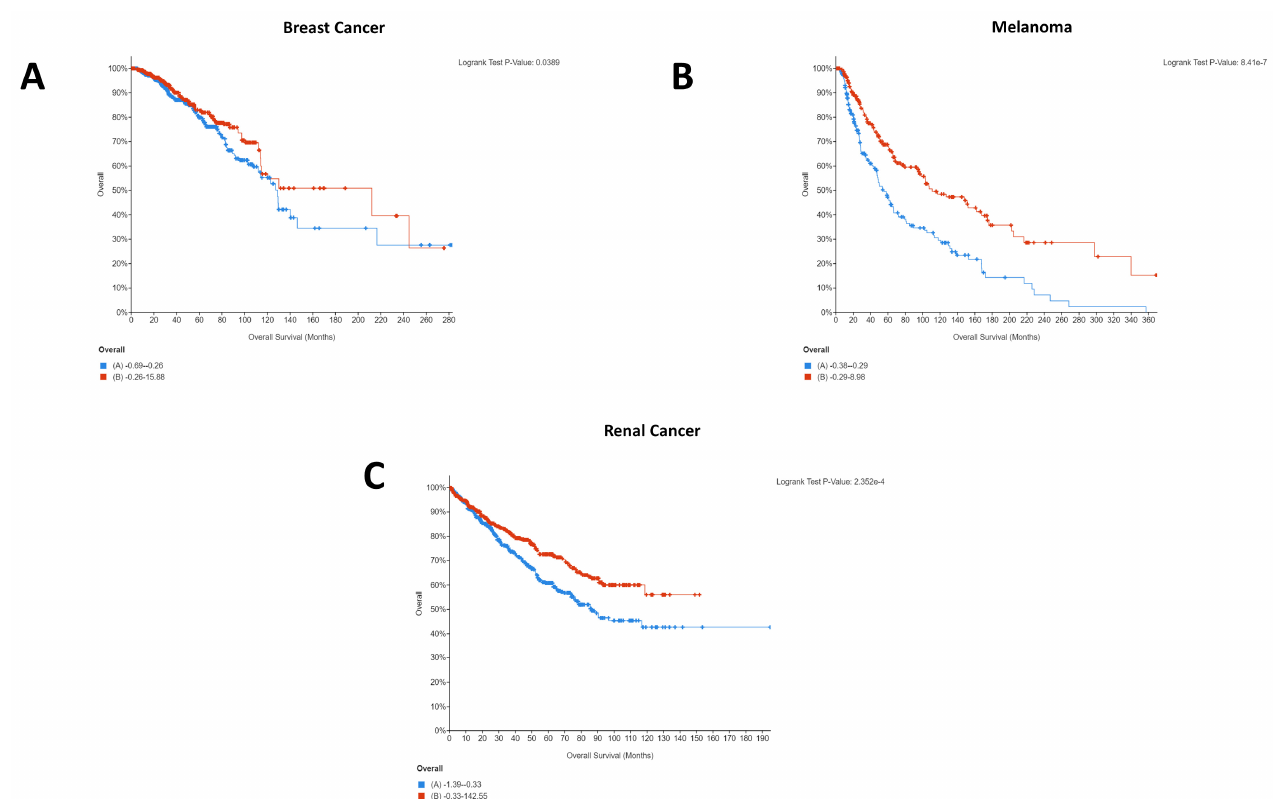
Figure 1. Statistically significant Kaplan–Meier plots for pan-cancer CD274 expression. In all cases, overall survival in months can be seen on the x -axis whilst percentage survived is shown on the y -axis. In all cases, high CD274 expression is shown in red whilst low CD274 expression is shown in blue. Data were generated using the mRNA expression z- scores relative to diploid samples (RNA Seq V2 RSEM) for the studies described in the Materials and Methods. CD274 expression was a significant factor for patient survival only in breast cancer ( A ), melanoma ( B ), and renal cancer ( C ). As such, bladder, cervical, colorectal, esophageal, gastric, head and neck, liver, lung, lymphoma, mesothelioma, ovarian, and pancreatic cancers have not been shown here but are available in Figure S1. Additionally, the mesothelioma study included (Mesothelioma (TCGA, Firehose Legacy)) lacked usable Kaplan–Meier survival